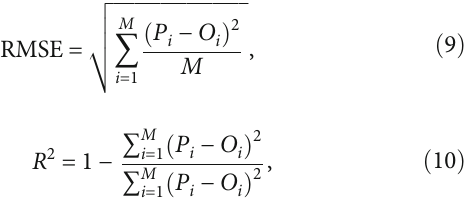
ffiffiffiffiffiffiffiffiffiffiffiffiffiffiffiffiffiffiffiffiffiffiffiffiffiffi RMSE =